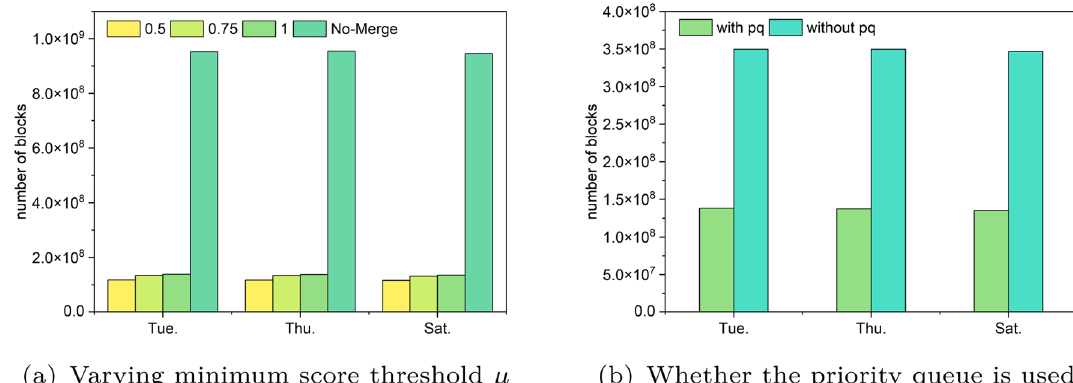
Fig. 20 Performances of merging cells (Algorithm